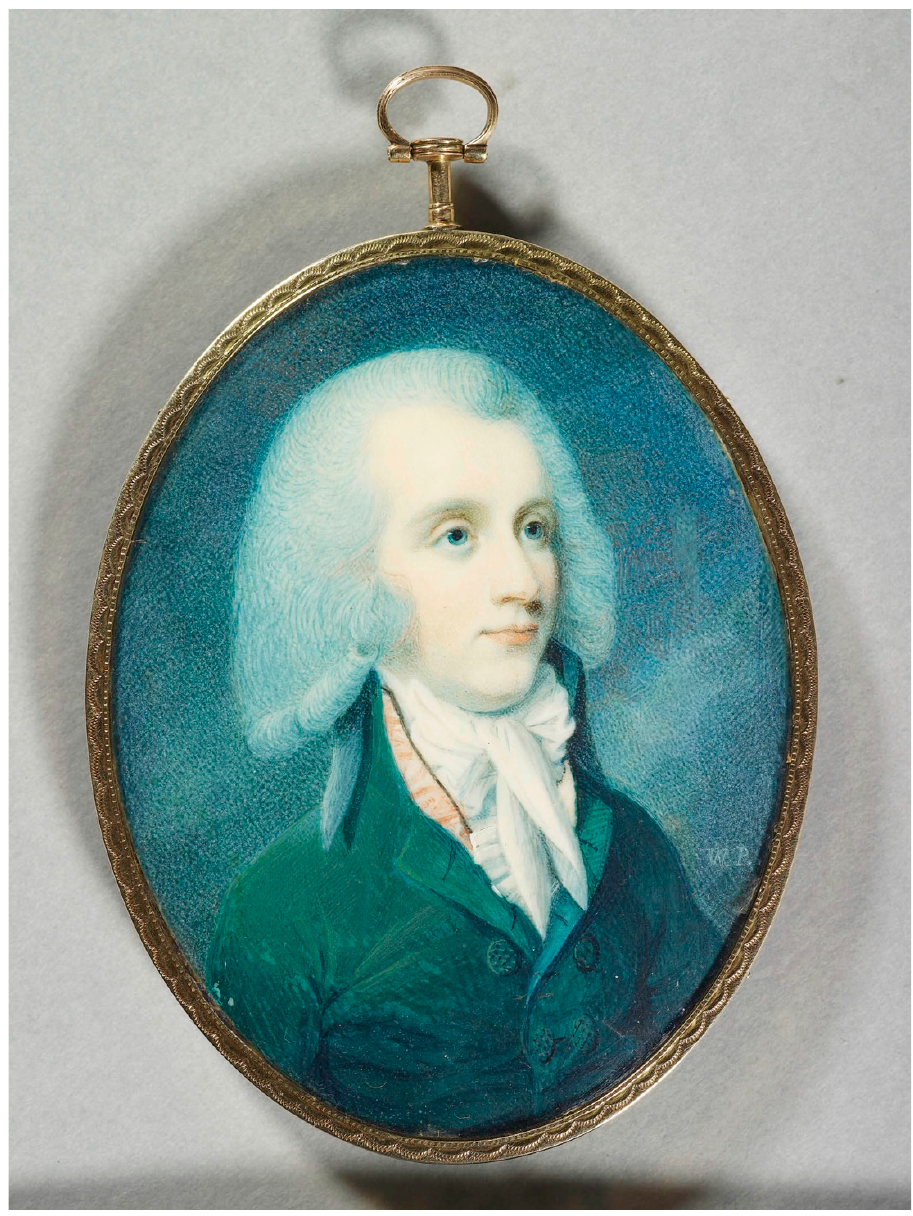
Figure 4. William Pether, Portrait of a Gentleman (Portrait a Man formerly called Sir Nathaniel Dance Holland (1734–1811), c. 1790, watercolor on ivory laid on card, 90 × 70 mm. Royal Collection Trust, London. Credit line: Digitized by Royal Collection Trust/© Her Majesty Queen Elizabeth II 2022.